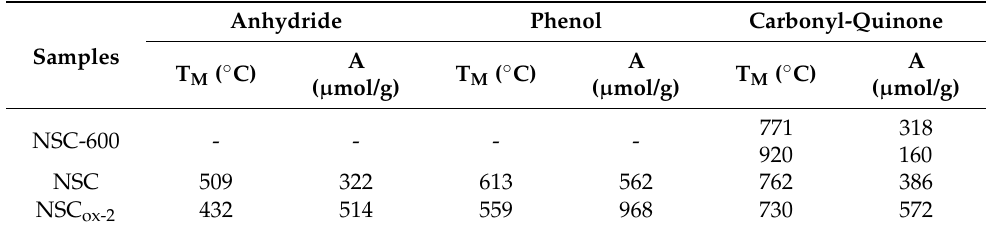
Table 3. Results of the deconvolution of CO-TPD spectra using a multiple Gaussian function.